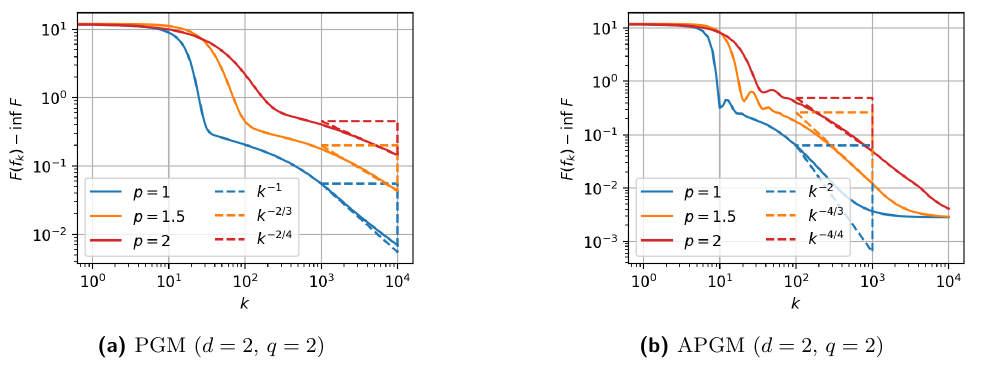
Figure 7 Convergence of PGM and APGM vs. theoretical rates (up to log factors) in a sparse deconvolution problem with H = λ ∥ µ ∥ and d = 2. Here p refers to the parameter of η p and p = 1 refers to η hyp . The objective has structure (II) so q = 2 in the rates of Table